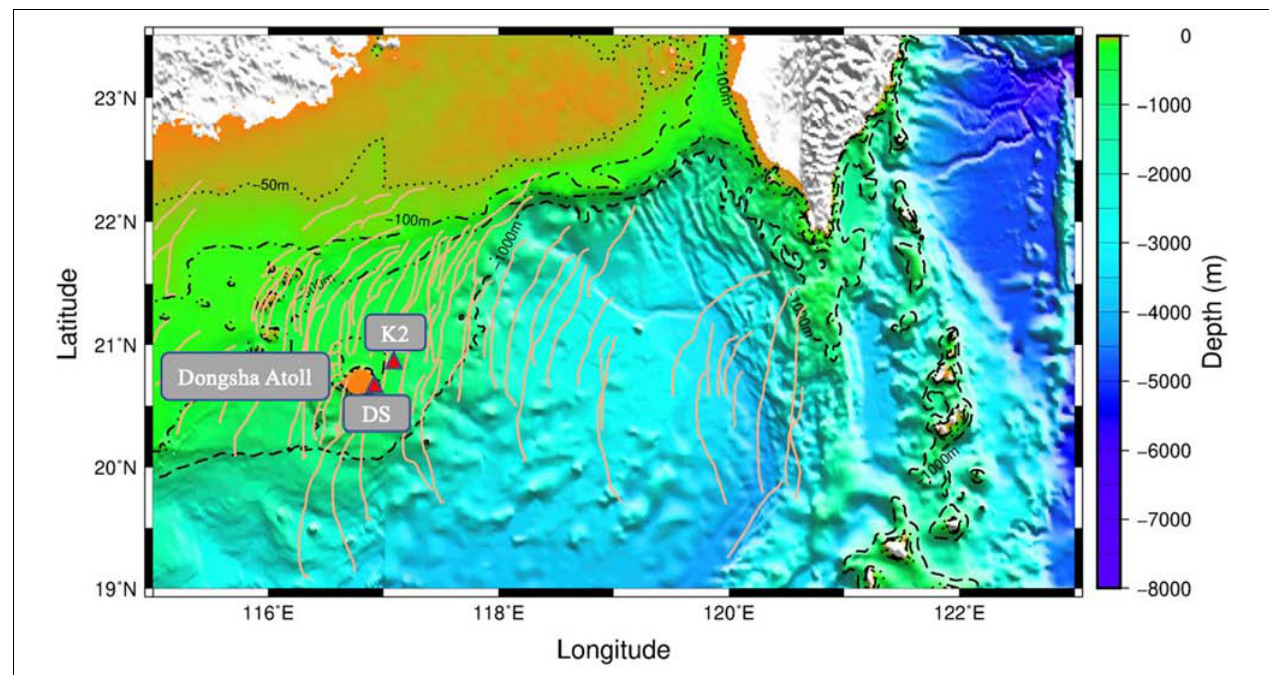
FIGURE 1 | Map of the northern South China Sea showing the locations of Dong Atoll and the sampling stations. Orange lines are internal wave packets observed in the satellite images acquired from 1995 to 2001 reported by Zhao et al. (2004).